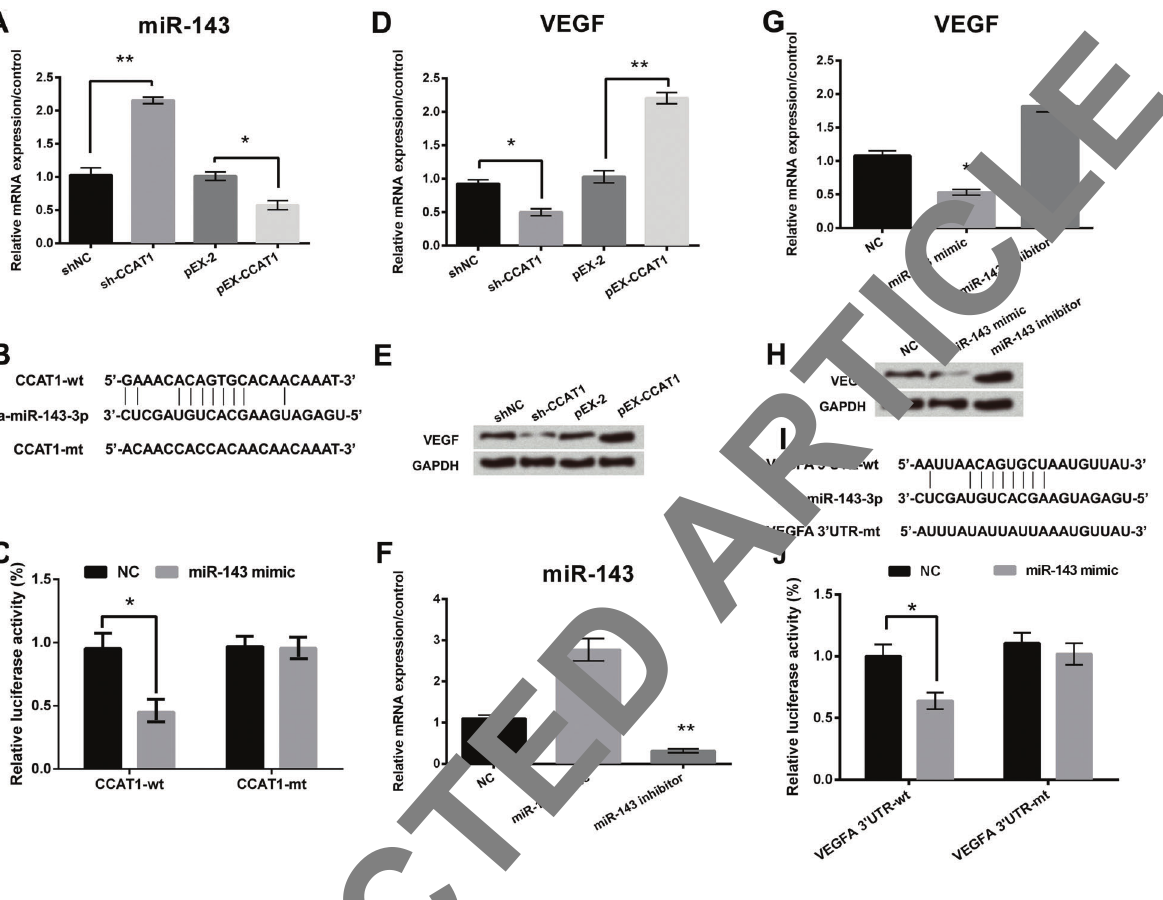
Figure 3. CCAT1 promoted the up-regulation of VEGF via inhibition of miR-143. FTC-133 cells were transfected with CCAT1 expressing vector, CCAT1 shRNA, miR-143 mimic, or miR-143 inhibitor. A , mRNA expression of miR-143 was detected in FTC-133 cells using qRT- PCR. B , The predicated miR-143 binding site of CCAT1 (CCAT1-wt) and the designed CCAT1-mt are indicated. C , The binding relationship between CCAT1 and miR-143 was assessed using dual-luciferase reporter assay. D , mRNA levels of VEGF in FTC-133 cells were detected using qRT-PCR. E , The protein level of VEGF with sh-CCAT1 or pEX-CCAT1 was analyzed using western blot analysis. F , G , mRNA levels of miR-143 and VEGF with miR-143 mimic or inhibitor were tested using qRT-PCR. H , The protein level of VEGF with miR-143 mimic or inhibitor were detected using western blot analysis. I , The predicted miR-143 binding site of VEGF 3 0 UTR (VEGF 3 0 UTR-wt) and the designed VEGF 3 0 UTR-mt are indicated. J , The binding relationship between miR-143 and VEGF 3 0 UTR